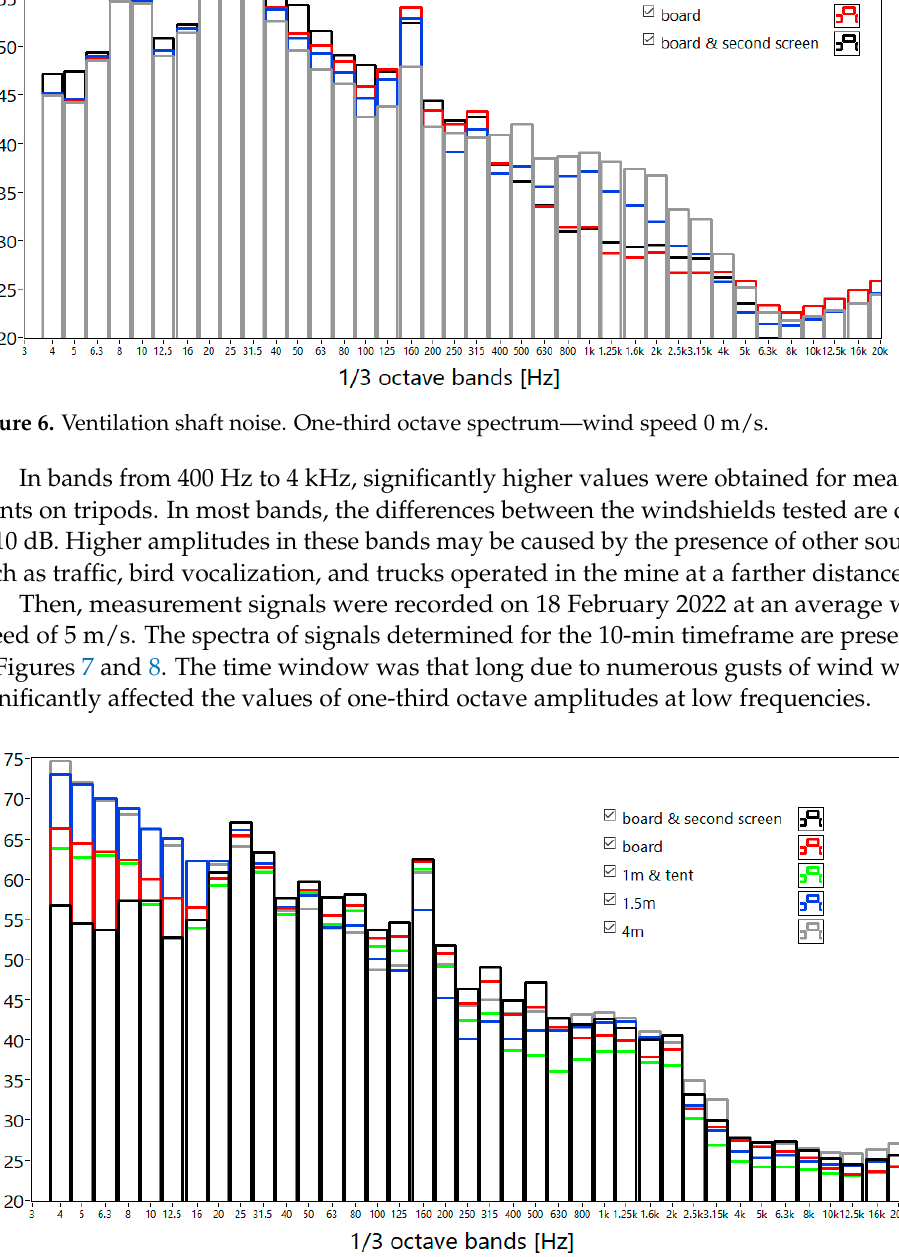
10 of 21 Figure 5. Ventilation shaft noise. Amplitude-frequency spectrum—wind speed 0 m/s. Figure 6 shows the one-third octave spectra for all measurement variants during windless weather. In frequencies below 50 Hz, there are no significant differences between the measurements at the height of 4 m, 1.5 m, and on the board with a double shield. The most significant difference between the tested windshields was obtained for the 40 Hz band, which was approximately 5 dB, while on average the difference was less than 1.5 dB. Significant discrepancies are visible for the 160 Hz band. The largest amplitudes for these components were obtained on the board, the smallest at the height of 4 m. The dif- ference was approximately 7 dB.